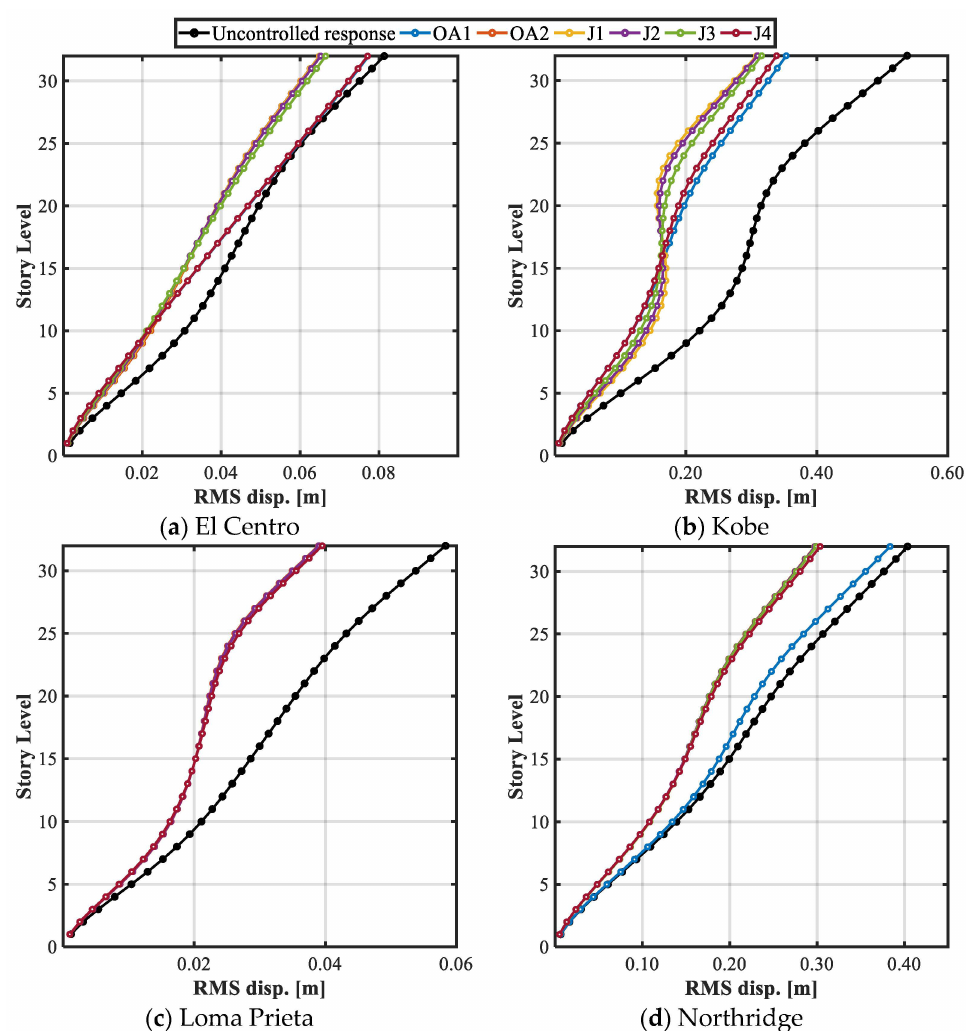
Figure 10. RMS displacement at each story level of the structure equipped with TMDs with µ =